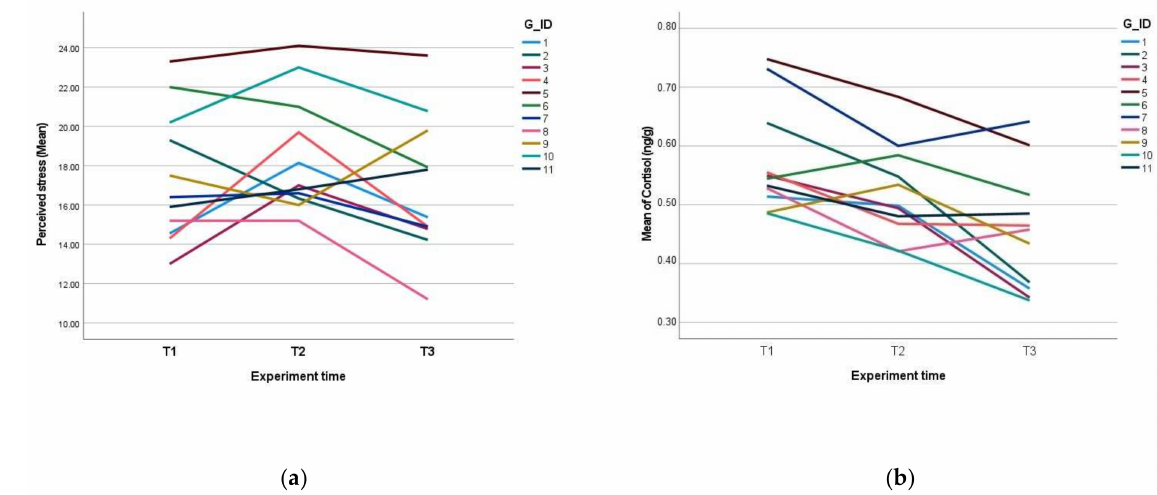
Figure 1. The degree of perceived stress and hair steroid hormone cortisol levels in groups during three time points (T1, T2, and T3): ( a ) perceived stress is measured using the perceived stress scale, in which a score of between 14–26 indicates moderate stress levels; ( b ) hair steroid hormone cortisol levels